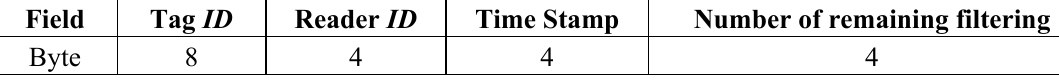
Table 1. Structure of the RFID data packet.